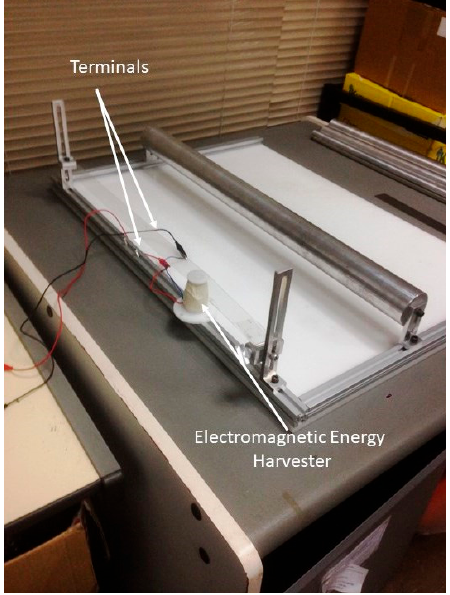
Figure 8. The full experimental system of an energy harvester.